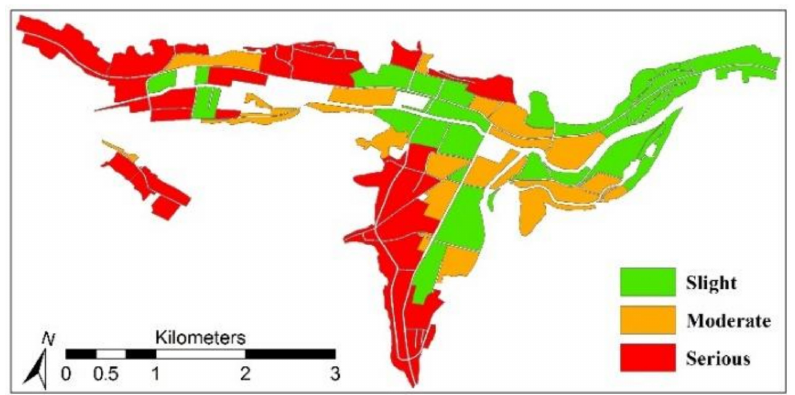
Figure 2. The block-level reference map of building damage in the Yushu study site.